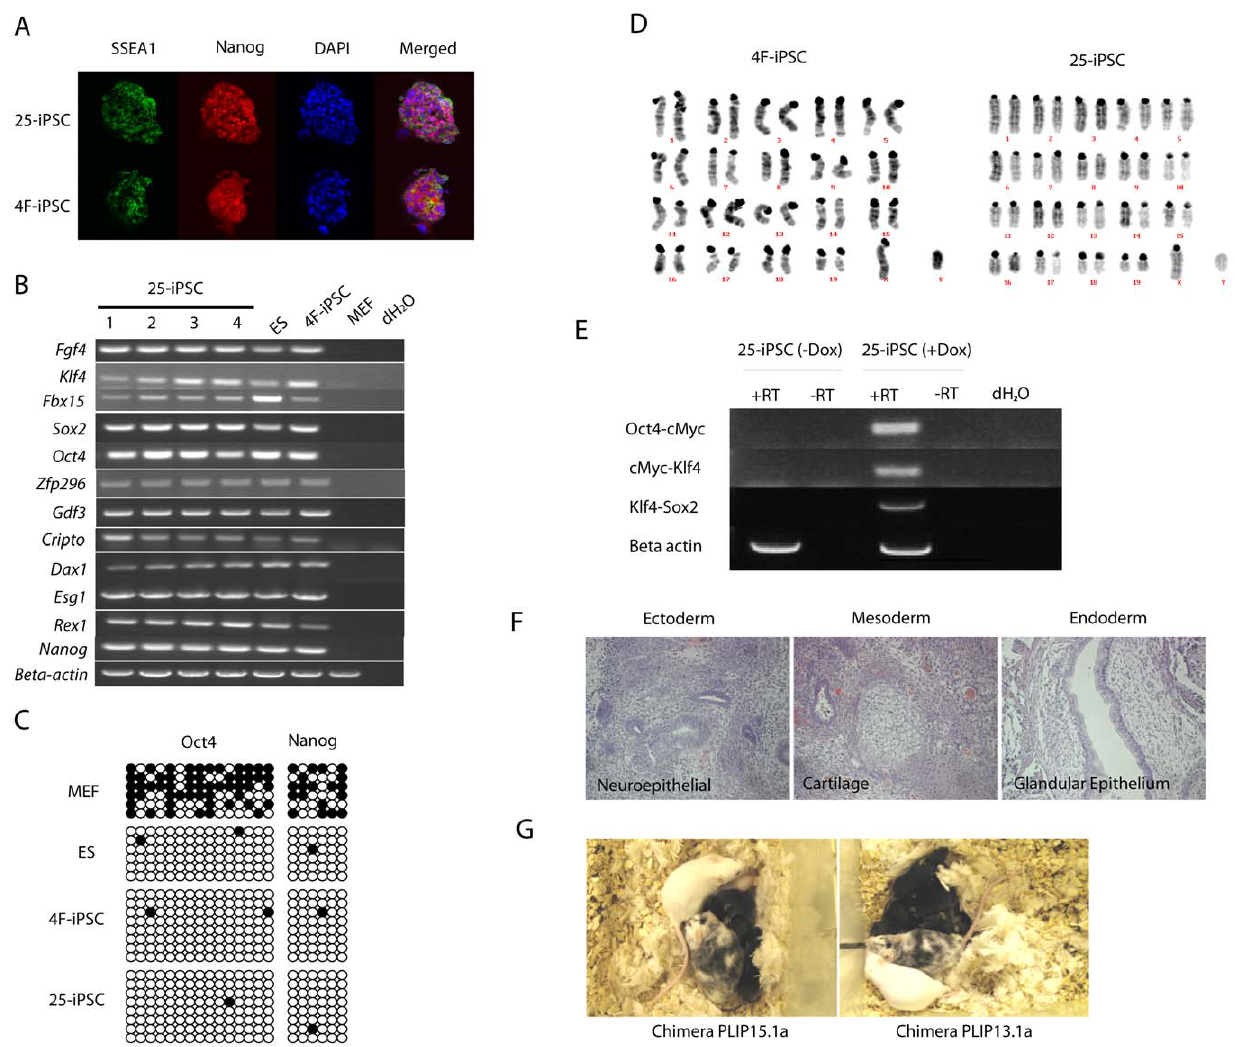
Figure 3. Characterization of 25-iPSCs. a. Immunofluorescence-staining of iPSCs to detect SSEA1 and Nanog expression. DNA was stained with DAPI (blue). b. RT-PCR analysis of pluripotency gene expression in 25-iPSCs and 4F-iPSCs. MEFs and ES cells serve as the negative and positive controls, respectively. Beta-actin was used as the PCR control. dH2O: no DNA template. c. Bisulfide genomic sequencing of the promoter regions of Oct4 and Nanog loci to detect CpG methylation. Open and filled circles represent unmethylated or methylated CpG dinucleotides, respectively. d. Normal karyotypes in a male 4F-iPS cell and a male 25-iPS cell. e. No exogenous Yamanaka factor expression in 25-iPSCs. RT-PCR was performed using primers to amply OCKS junctions (Primer sequences are in Table S2). Robust expression from PB-TRE-OCKS was detected in the presence of Dox. No expression was found if Dox was removed from the media. + RT: reverse transcriptase; -RT: no reverse transcriptase in reverse transcription. Beta-actin was used as the PCR control. f. Haematoxylin eosin stained sections of teratomas derived from 25-iPSCs. Cells representing all three germ layers were readily identifiable. g. Germline-transmission pups (agouti) from two chimeras derived from 25-iPSCs that were crossed to wild-type C57BL6 (albino) females. doi:10.1371/journal.pone.0040938.g003 these targets are being actively repressed by miR-25 in our iPSCs, sorted starting with the most down-regulated in the miR-25 we compared the 25-iPS microarray samples against the 4F-iPS transfection experiment. The only 7mers that were enriched samples. We observed that these miR-25 candidate targets were within the 3 9 UTRs of these down-regulated genes correspond to down-regulated in the 25-iPS cells ( p value 9 6 10 2 4 by a Wilcoxon words complementary to the miR-25 seed sequence, indicating that the experimental profile can be used to derive lists of genes signed-rank test) (Fig. 5 C ). From these targets, we prioritized a list enriched for direct targets of miR-25 (Fig. 5b). From this of 12 gene by selecting those that were also up-regulated in the Dgcr8 -deficient cells, besides being down-regulated in 25-iPSCs experiment we obtained a list of 72 transcripts, which were down-regulated after transfection of the miR-25 mimic, with a fold relative to 4F-iPSCs (Table 1). Of particular interest on this gene change of at least 1.2 and with an estimated false discovery rate list were Wwp2 and Fbxw7 , which have been shown to modulate Oct4 and c-Myc respectively [55,56,57,58,59,60]. less than 10%. Of these genes, 54 possessed at least one seed- matching site for miR-25 in their 3 9 UTR and constitute the initial set of experimentally derived miR-25 targets (Table S4). To test if